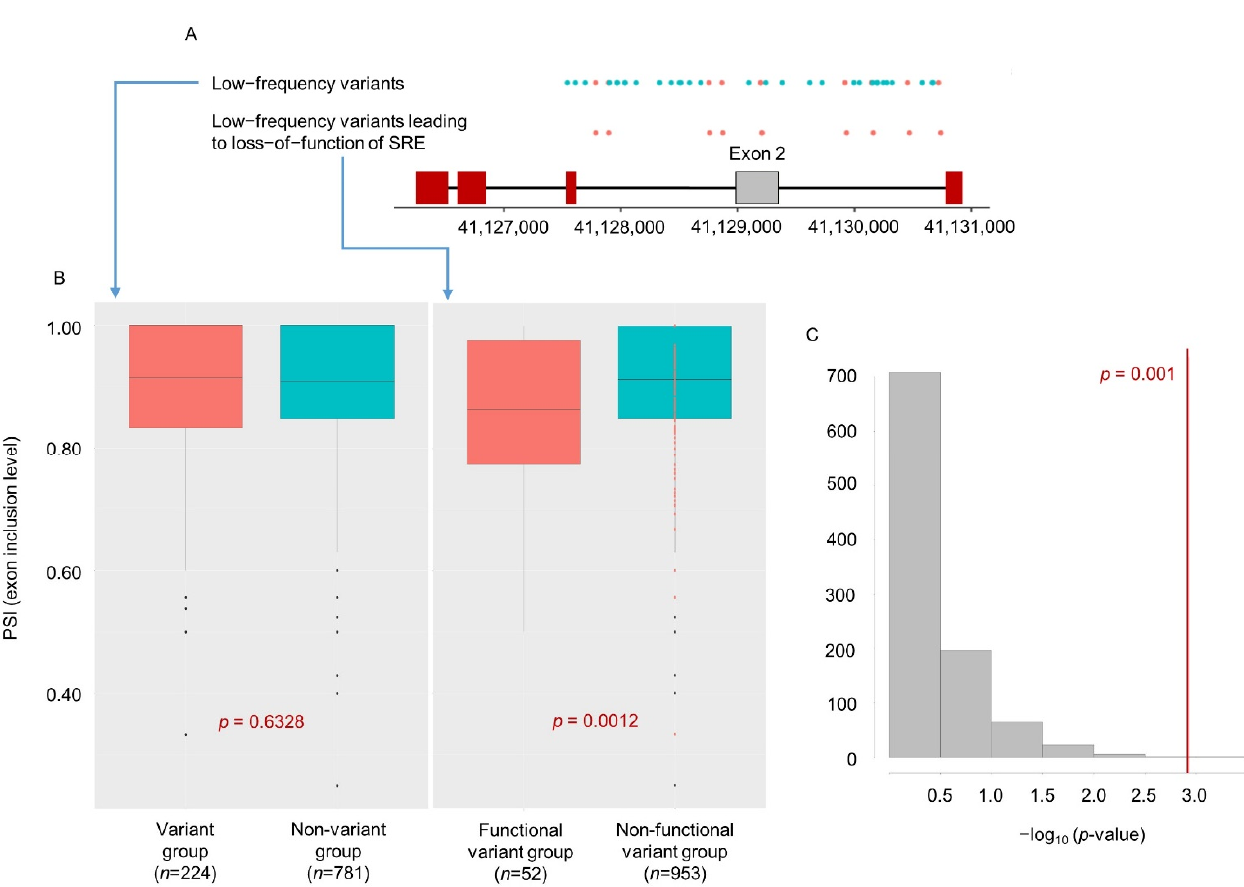
Table 1. Statistical difference between groups with and without SRE-impacting low-frequency var- iants.